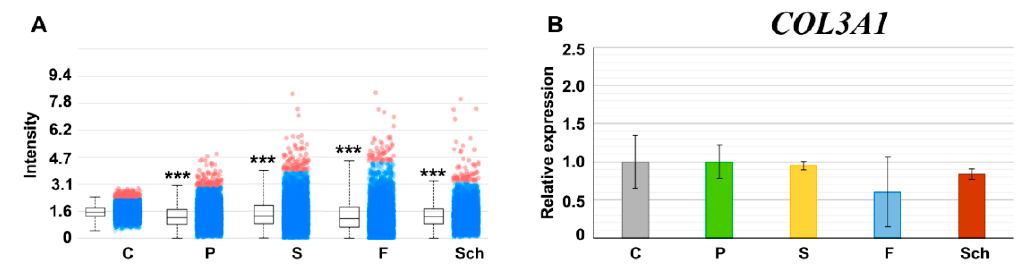
Figure 12. MALDI-TOF mass spectrometry analysis of collagen III fragment and gene expression of COL3A1 . ( A ): Intensity box plot for the m / z 1679.873 ± 0.100 Da collagen α -1(III) chain fragment GAPGFRGPAGPNGIPGEK 12 days post-excision in the dermis of rats fed 64 days a standard diet